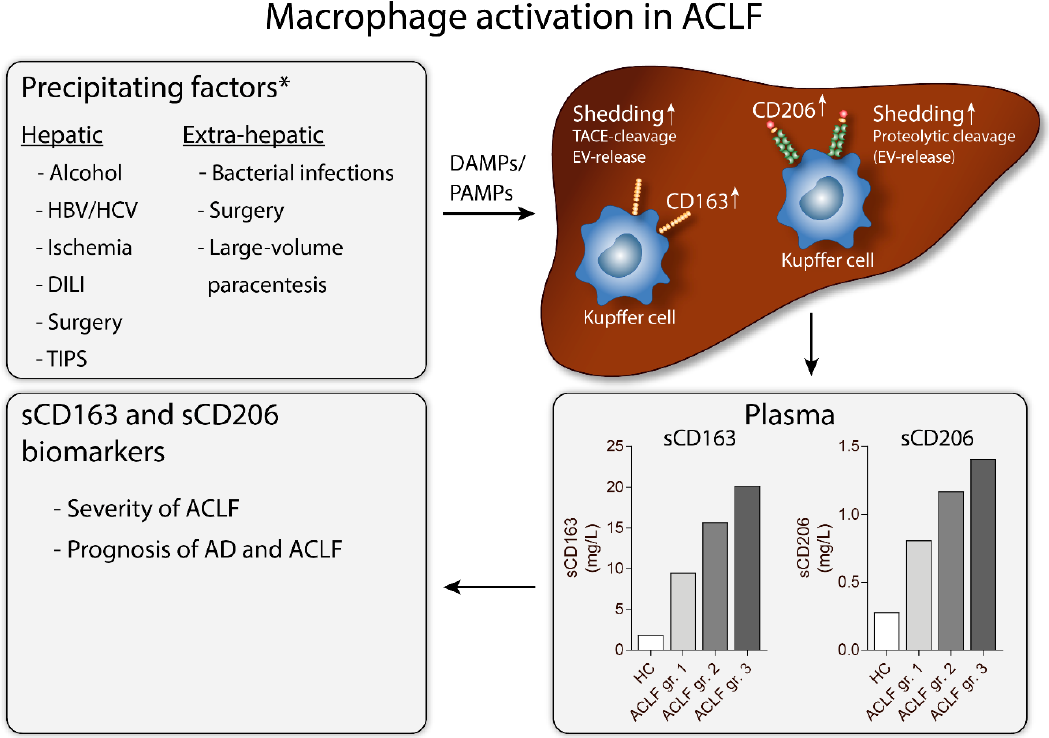
Figure 1. Macrophage activation in patients with acute-on-chronic liver failure (ACLF). Hepatic or extra-hepatic precipitating factors result in the release and production of PAMPs and DAMPs. This leads to increased CD163 and CD206 expression in liver resident macrophages (Kupffer cells), along with increased shedding of the receptors from the Kupffer cells. CD163 shedding is mediated through TACE-cleavage [7] and EV-associated release [8], whereas CD206 shedding is mediated through proteolytic cleavage [9] and possibly EV-associated release (unpublished data). The relationship